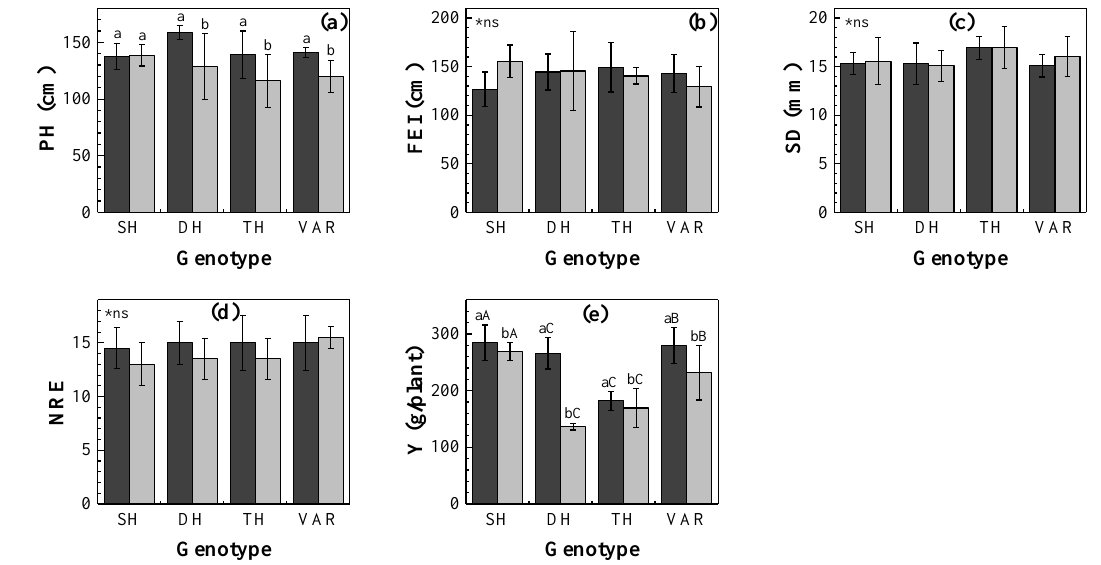
Figure 3. Impact of water-deficit stress on the four maize genotypes under study in the 21–30 DAE (days after emergence) period: ( a ) plant height (PH, cm); ( b ) height of the first ear insertion (FEI, cm); ( c ) stem diameter (SD, mm); ( d ) number of rows per ear (NRE); and ( e ) yield per plant (Y, g · plant − 1 ). Dark grey bars and light grey bars correspond to without water restriction (WWR) and water restriction (WR) conditions, respectively. Averages followed by the same uppercase or lowercase do not differ by the Tukey test at 5% probability. Lowercase letters compare the values of water regimes (WWR vs. WR) and capital letters compare values among genotypes. The bars represent the mean standard deviations. *ns = not significant.